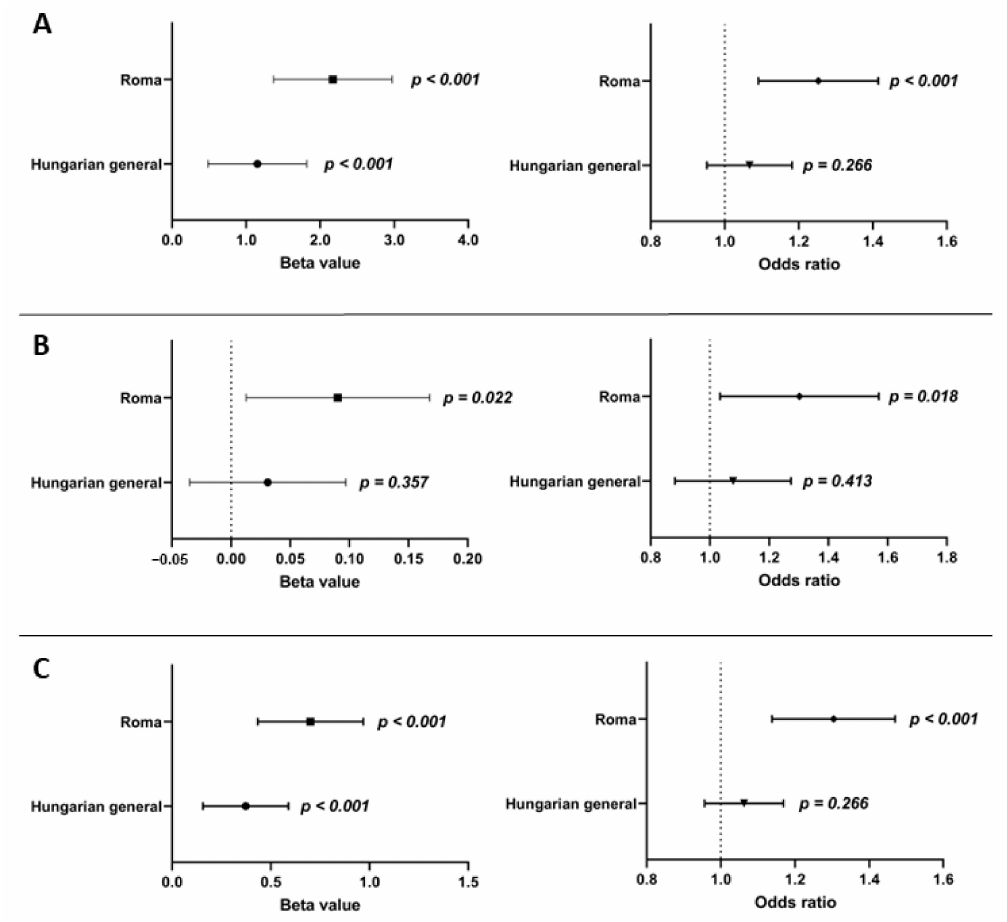
Figure 3. Effect of oGRS on the fasting insulin level ( A ), fasting glucose level ( B ), and HOMA—IR ( C ) as a continuous (in β value) and binary (in OR) outcome in the Roma and Hungarian general populations. The association was evaluated by using an adjusted (for age, sex, BMI, and treatments) linear regression model. Bonferroni corrected p value: